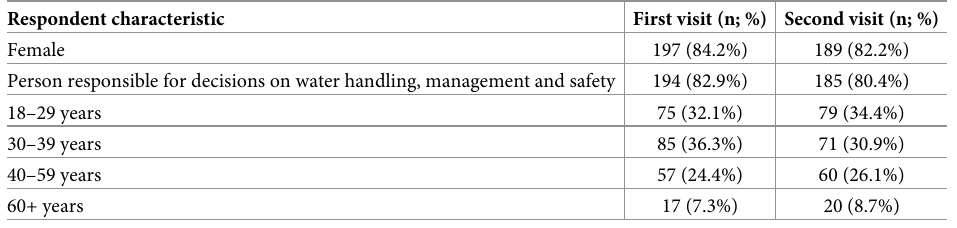
Table 1. Questionnaire survey respondent characteristics by initial and follow-up visit.